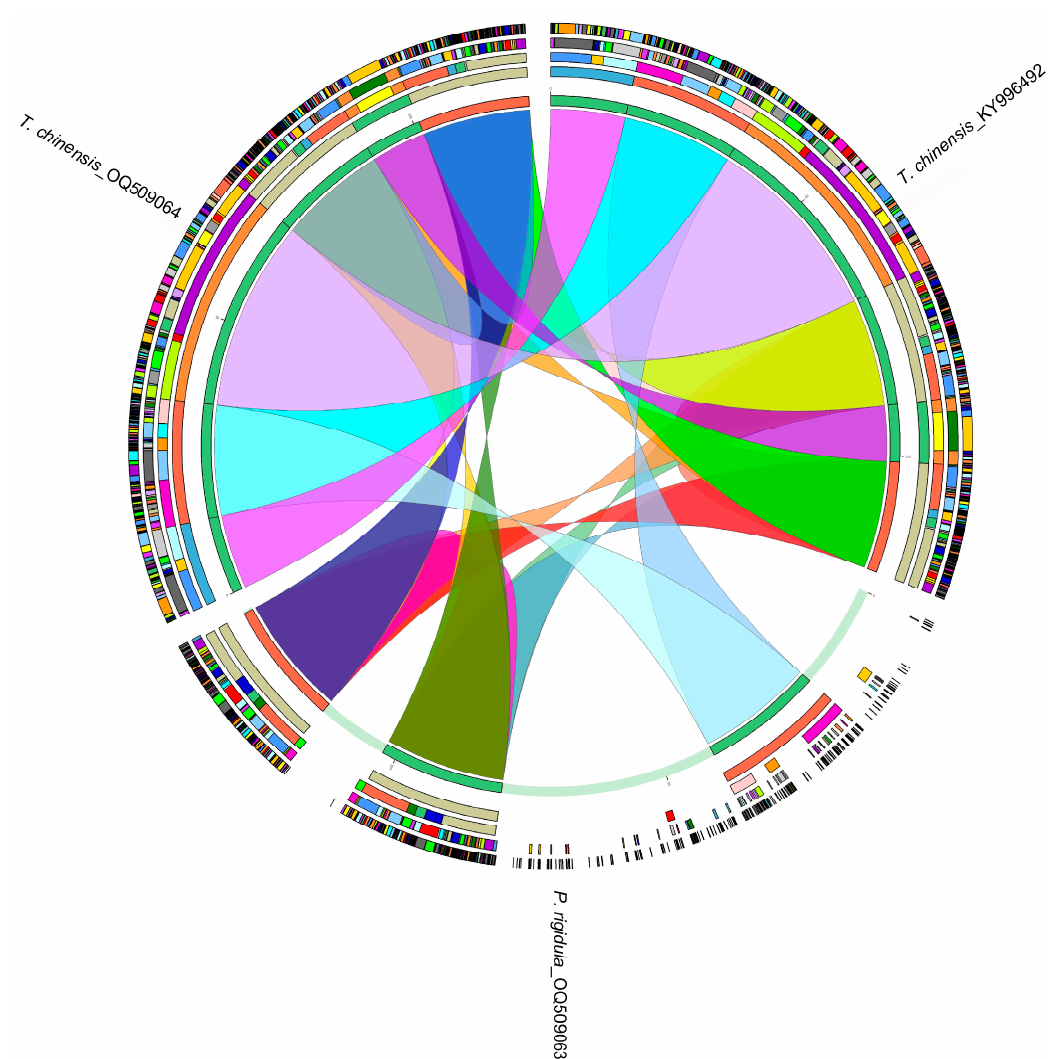
Figure 2. Homology analysis of the chloroplast genomes of P. rigidula and T. chinensis . The colored blocks and bands represent homologous regions.